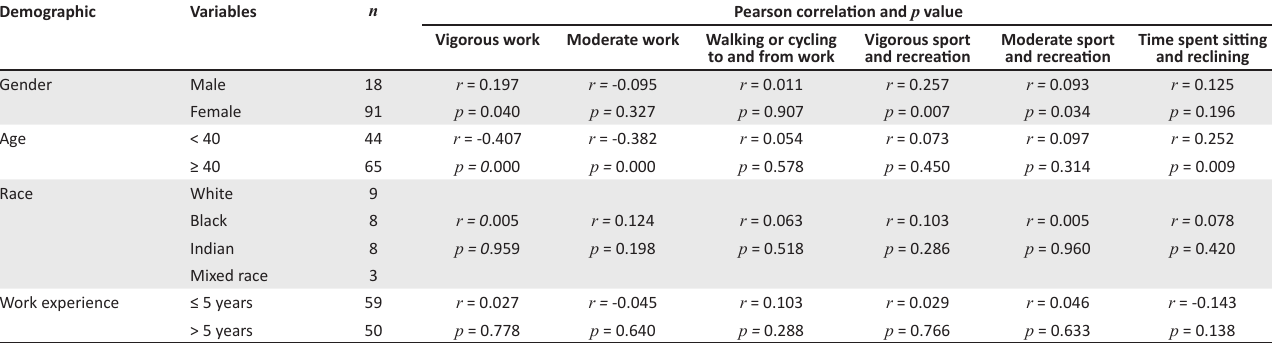
TABLE 6: Correlation between demographics and physical activities. Demographic Variables